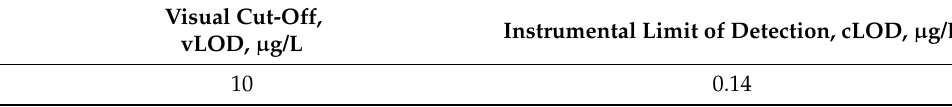
Table 1. Parameters of visual and instrumental detection of BPA in the developed LFIA. Visual